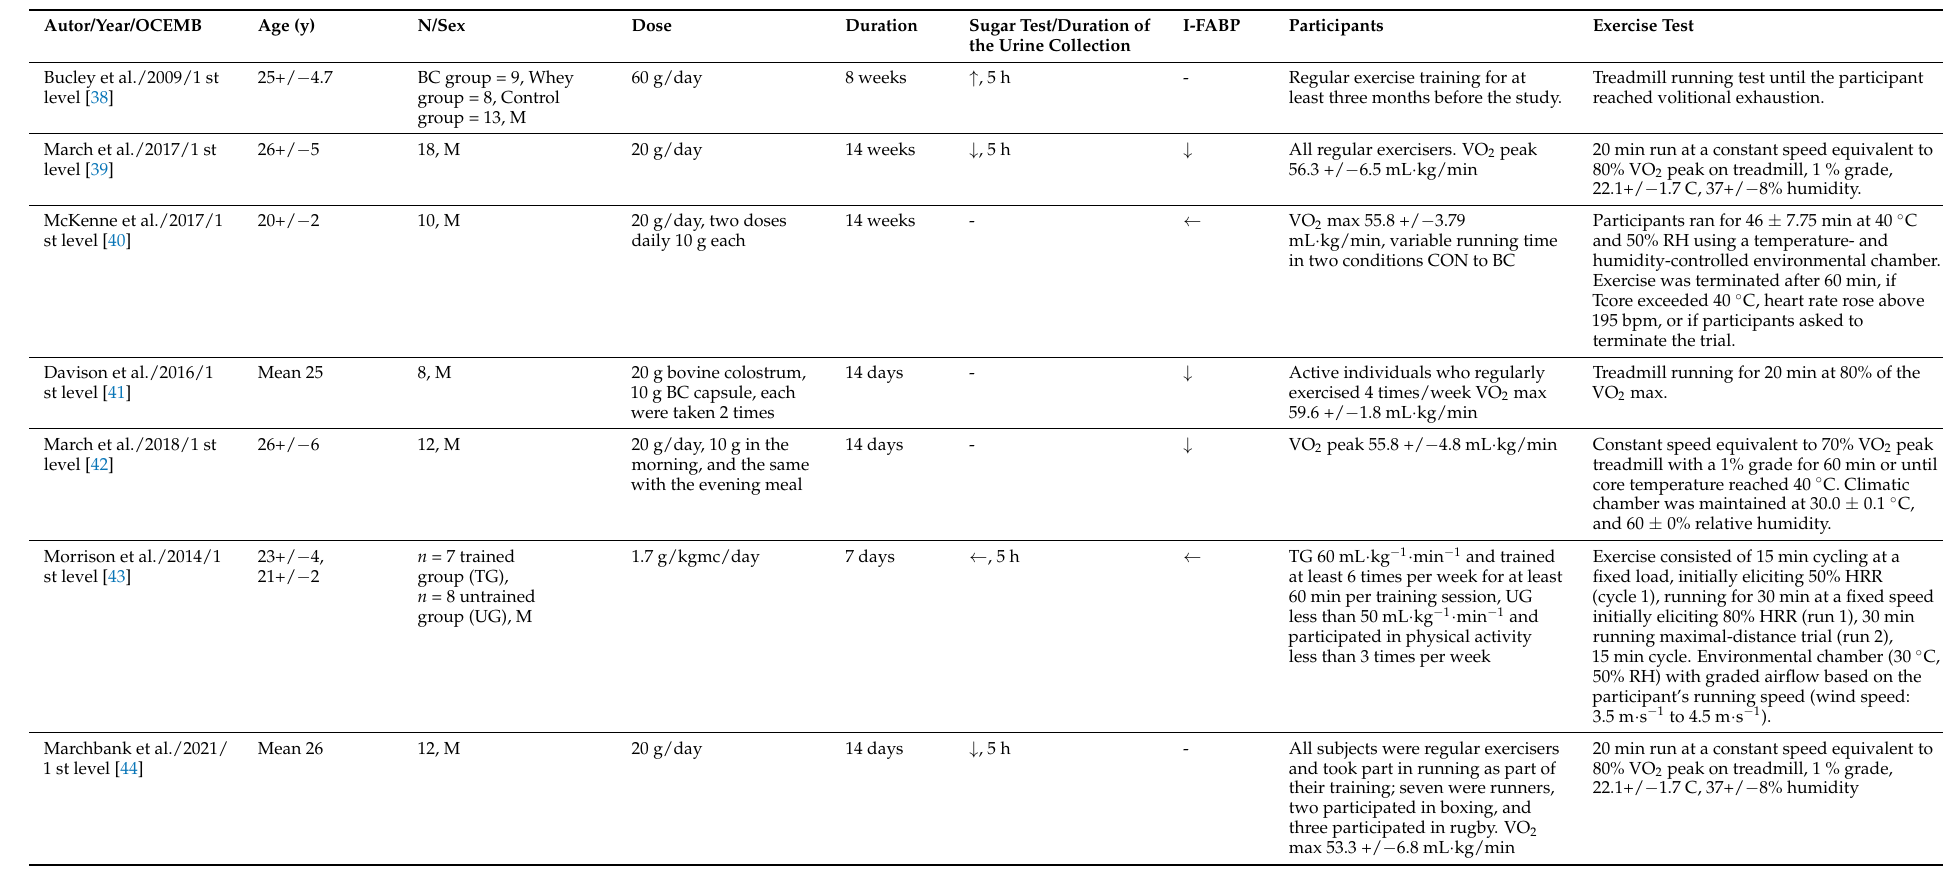
Table 3. Summary of studies analyzed for gut permeability alterations observed after Bovine Colostrum